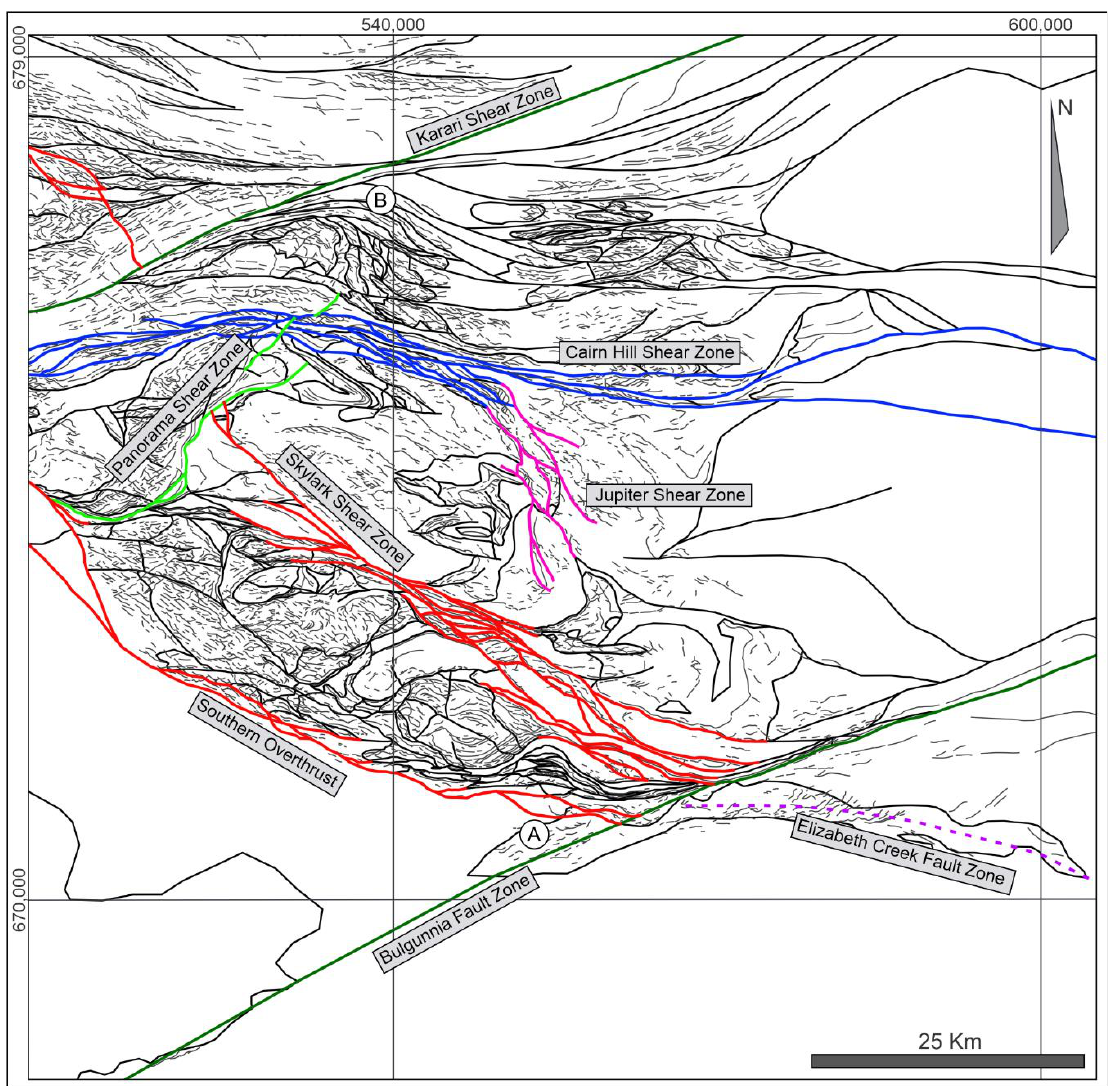
Figure 4. Structural architecture of the Mt. Woods Inlier with highlighted deep-seated lithospheric- scale structures, including the Karari Shear Zone, Bulgunnia Fault Zone, Elizabeth Creek Fault Zone, Jupiter Shear Zone, Skylark Shear Zone, Southern Overthrust, Panorama Shear Zone and Cairn Hill Shear Zone.